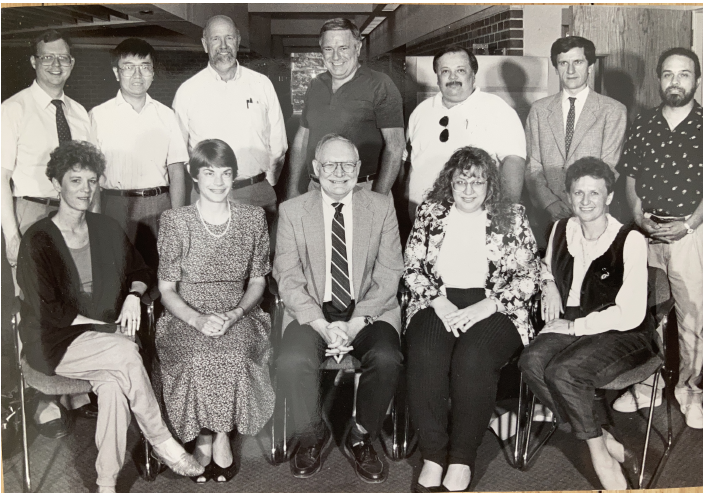
Figure 1: Gary Chartrand with 11 of his PhD